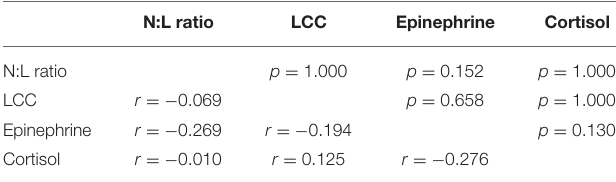
TABLE 1 | Association among neutrophil-to-lymphocyte ratio (N:L ratio), leukocyte coping capacity (LCC), plasma epinephrine, and cortisol measurements in 23 white rhinoceros bulls during capture and